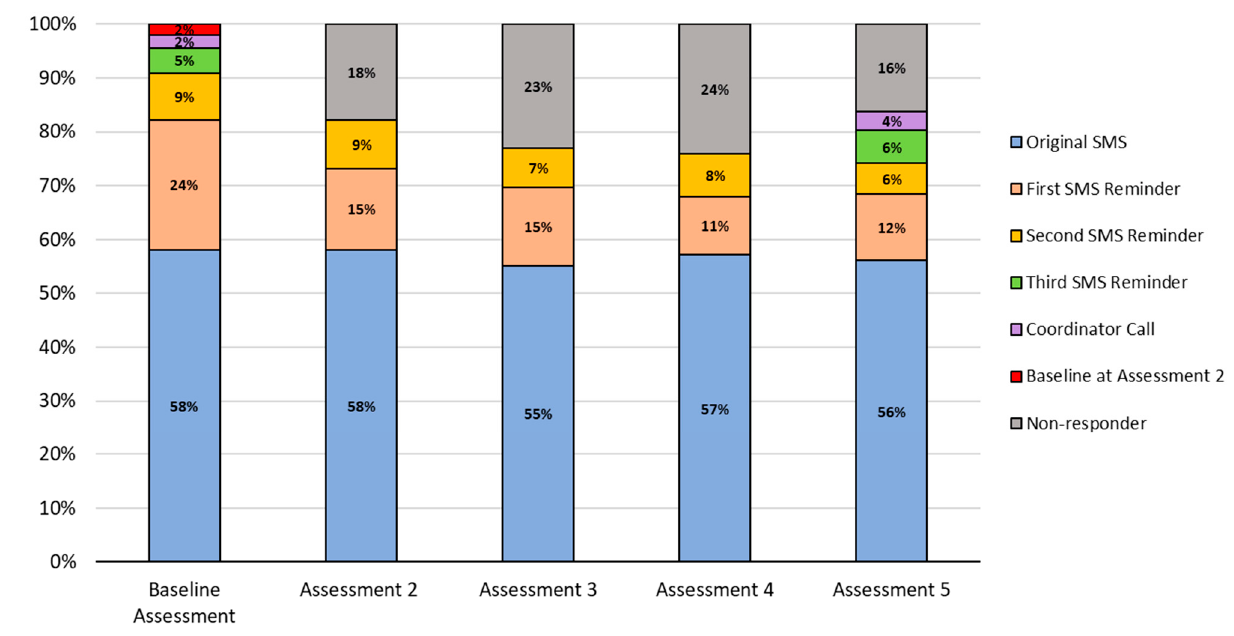
Figure 3. Enrolled caregiver ( n = 542) response rates by reminders 1 for SMS Baseline 2 through Assessment 5. 1 All assessments included two SMS reminder messages; a third SMS reminder, followed by coordinator call was protocol only for Baseline and Assessment 5. 2 For the 14 (3%) caregivers that completed Baseline Assessment at the second attempt (during Assessment 2), their response rates are included in the Assessment 2 data ( n = 10 responded to the original SMS and n = 2 responded to the second SMS reminder).